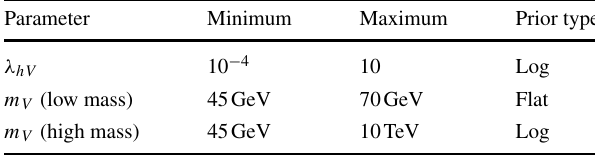
Table 3 Parameter ranges and priors for the vector DM model Parameter Minimum